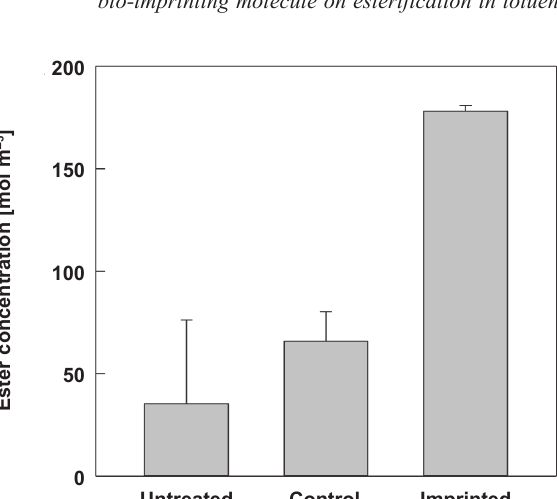
Fig. 1 – Effect of alkyl chain length of carboxylic acids as bio-imprinting molecule on esterification in toluene